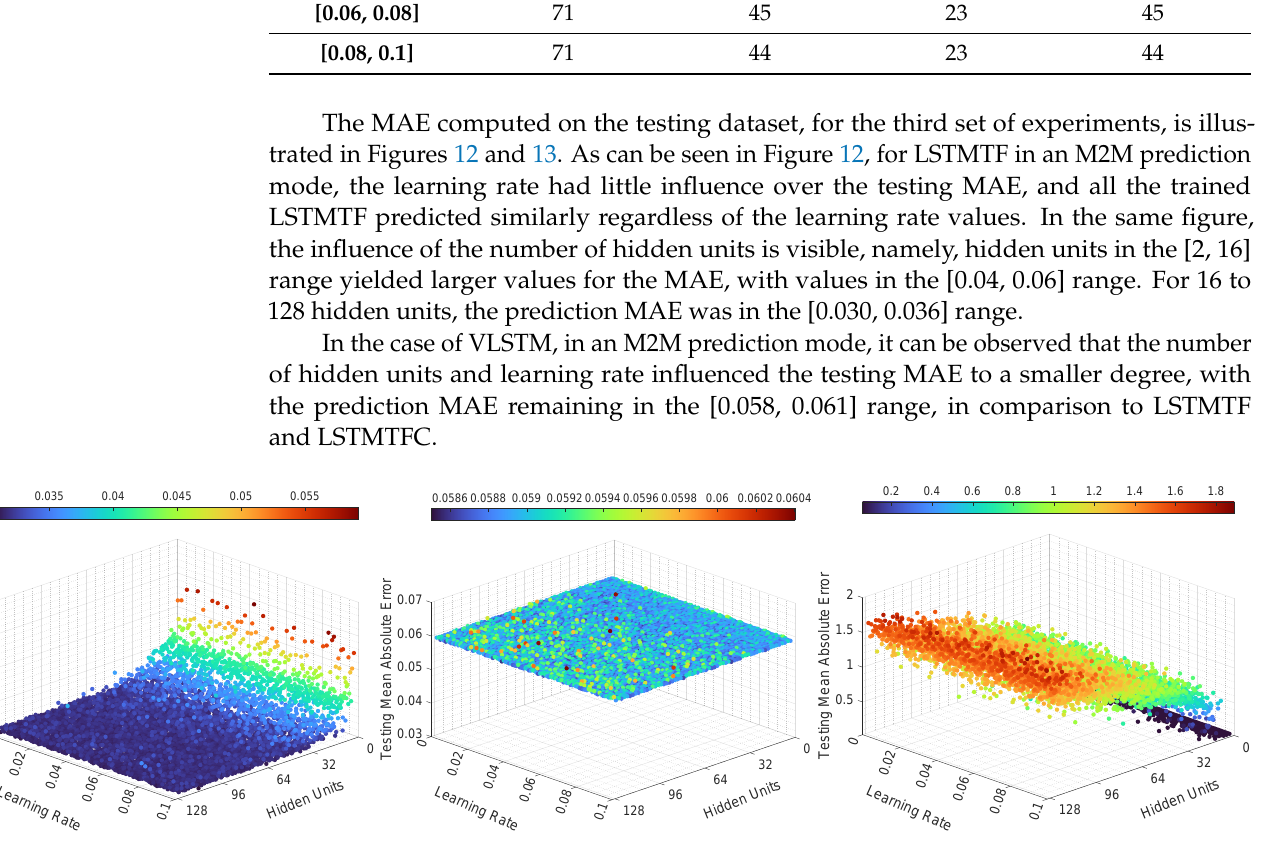
Figure 12. Illustration of the testing mean absolute error value for Experiment 3, LSTMTF ( left ), VLSTM ( middle ), and LSTMTFC ( right ), using a many-to-many prediction mode. For LSTMTFC using an M2M prediction method, the number of hidden units seem to have an inverse influence compared to LSTMTF, namely, for hidden units in the [2,